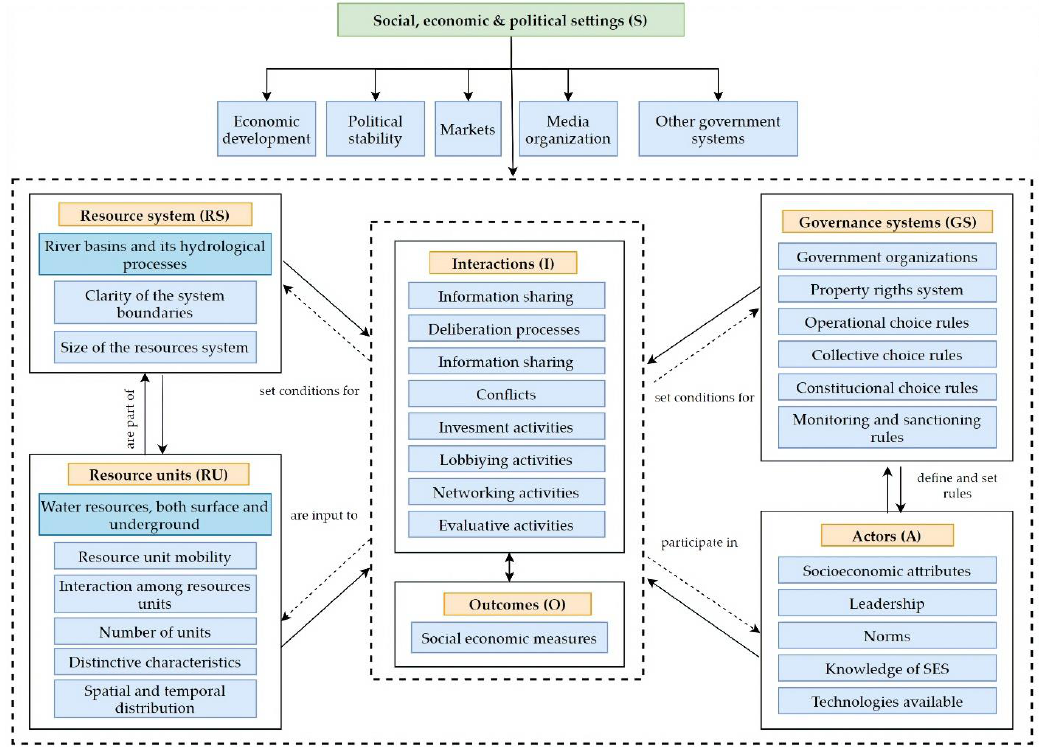
Figure 6. Socio-ecological system framework interactions of multilevel water governance in Nicaragua. Source: authors’ own creation, based on Hinkel, Bots [11].